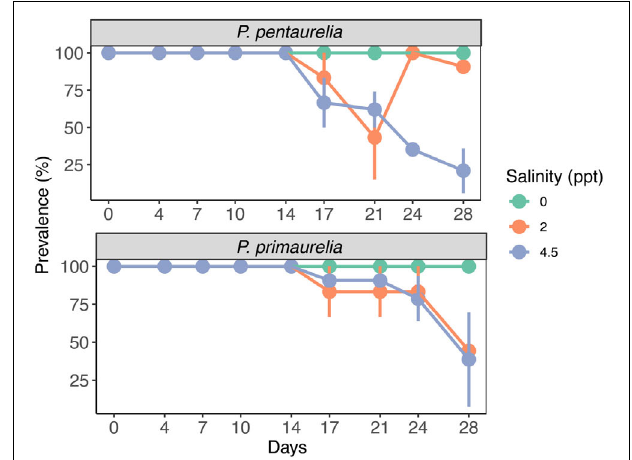
FIGURE 3 | Bacterial prevalence (%) of infected species P. pentaurelia and P. primaurelia at three different salinity concentrations (0, 2, and 4.5 ppt) over 28 days. Error bars represent the standard error ( n =